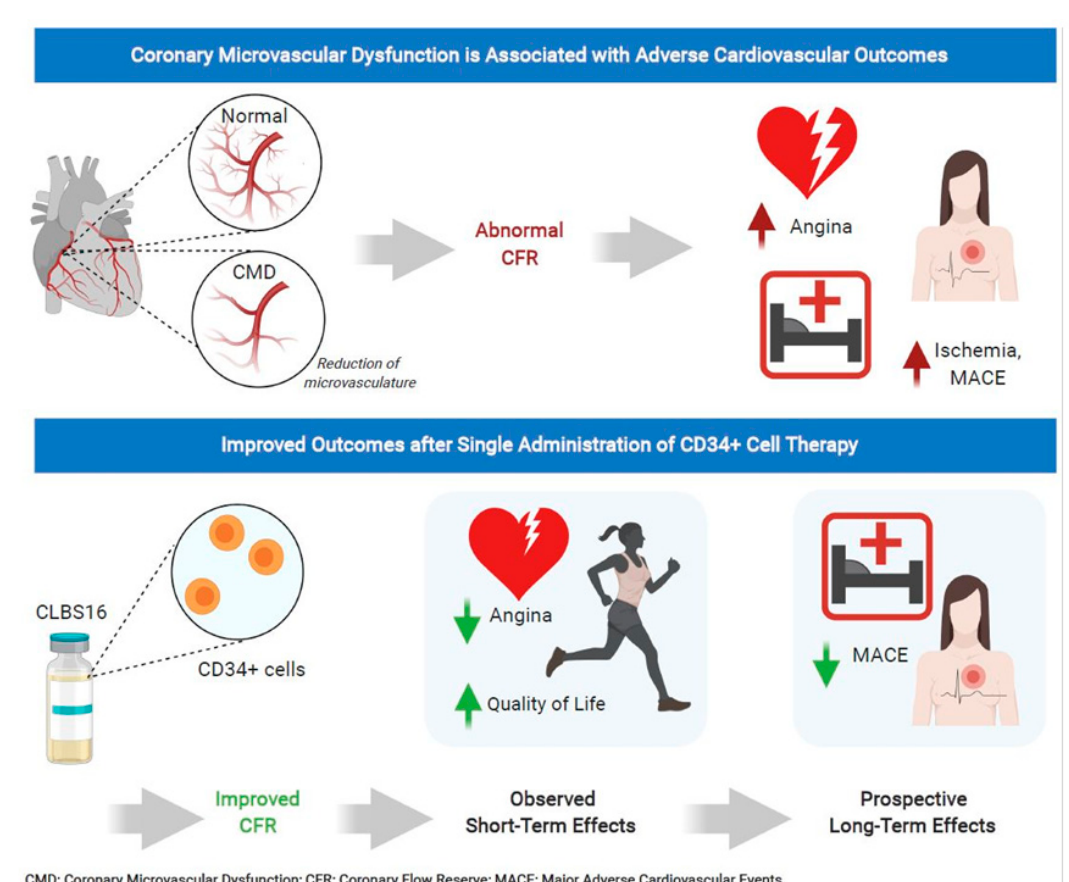
Figure 3. CD34 + cell therapy for patients with coronary microvascular dysfunction and refractory angina with no obstructive coronary artery disease. Results from the phase 1 ESCaPE-CMD trial (NCT03508609) showed that a single intracoronary infusion of autologous CD34 + cells in patients with coronary microvascular dysfunction and refractory angina with no obstructive coronary artery disease significantly improved coronary flow reserve, decreased angina frequency, and improved quality of life at 6 months.